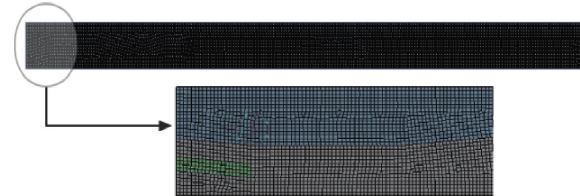
Figure 3: Computational mesh of nonpremixed micro-combustor.